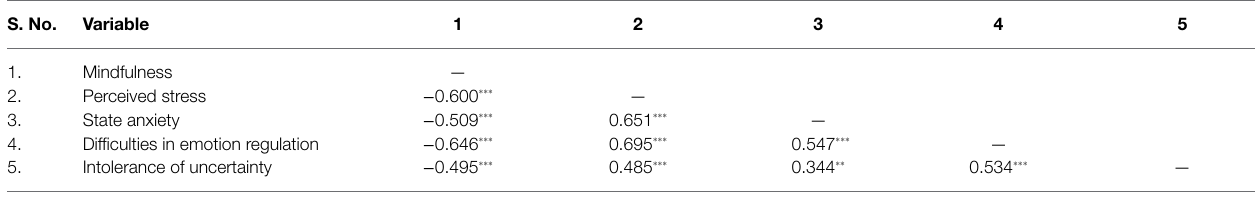
TABLE 2 | Correlations for study-dependent variables at T1.